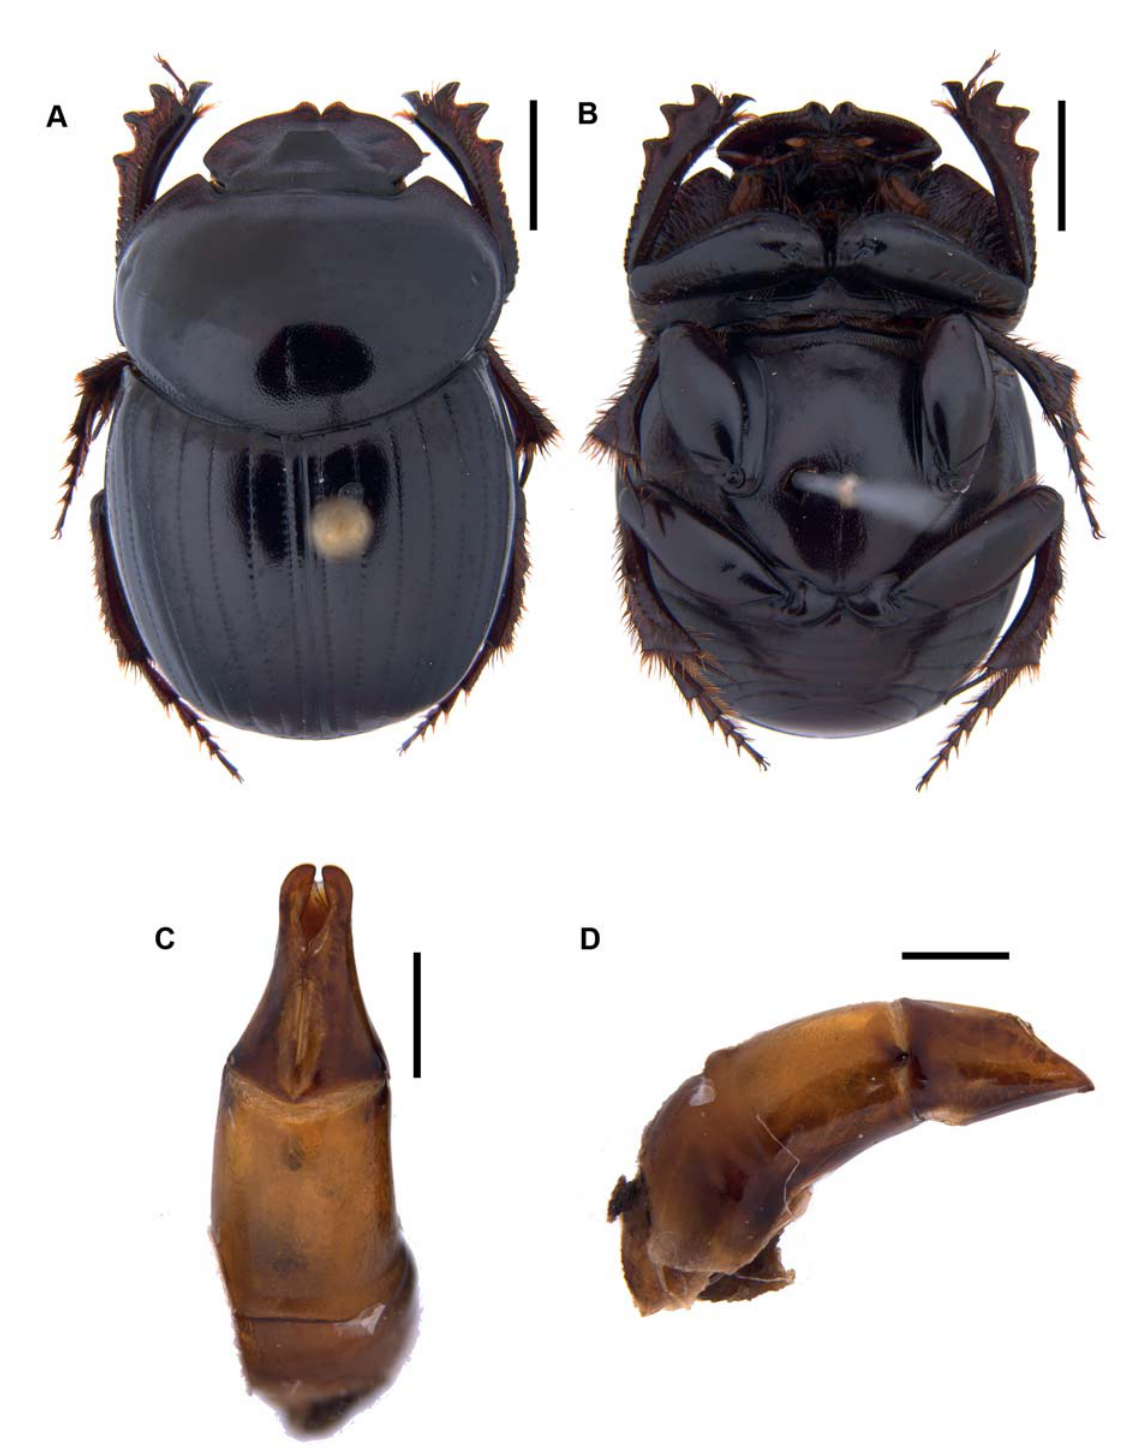
Fig. 2. Canthidium gigas Balthasar, 1939. A . Dorsal view. B . Ventral view . C . Dorsal view of aedeagus. D . Lateral view of aedeagus. Scale bars: 1